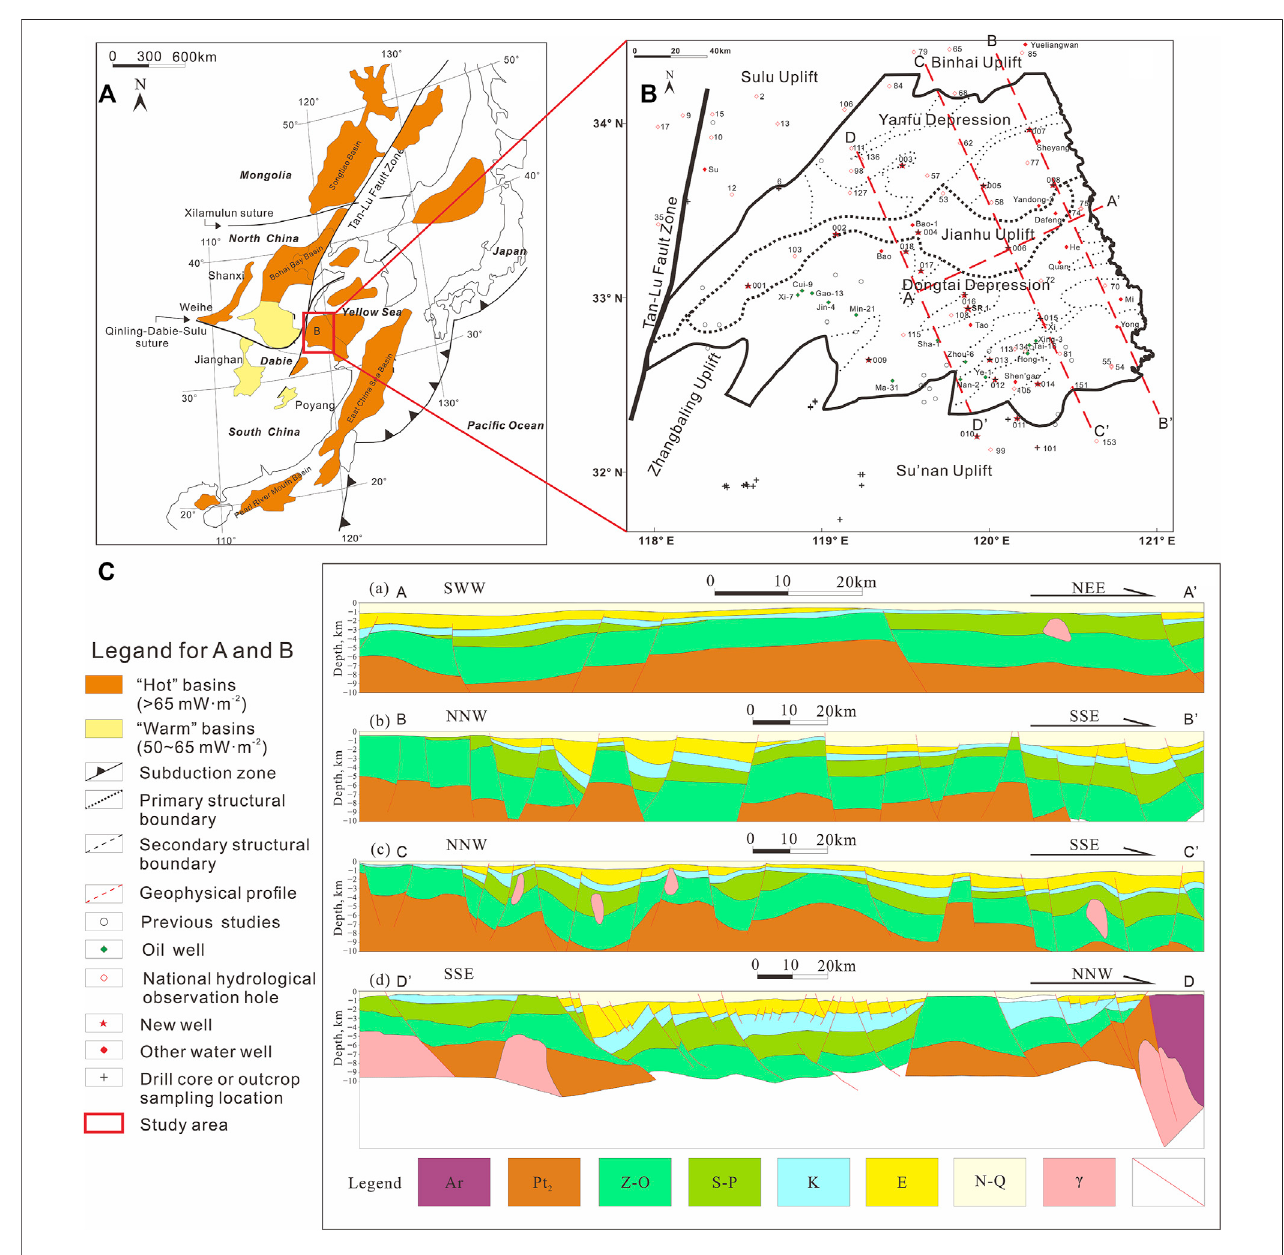
FIGURE 1 | Tectonic, geological interpretation sections and geothermal information of the North Jiangsu Basin. (A) is modi fi ed after Grimmer et al. (2002); (B) is modi fi edafterWangetal.(2020),Wangetal.(2021a); (C) (a,b,c)areintegratedgeologicalpro fi leswithjointinversionofresistivity,gravity,andmagneticdata,and (C) (d) isdepth-convertedseismicinterpretation, (C) (a,c)aremodi fi edfromWangetal.(2020),(b)isfromWangetal.(2021a),(d)isintegratedfromChen(2010)andQiaoetal. (2012).